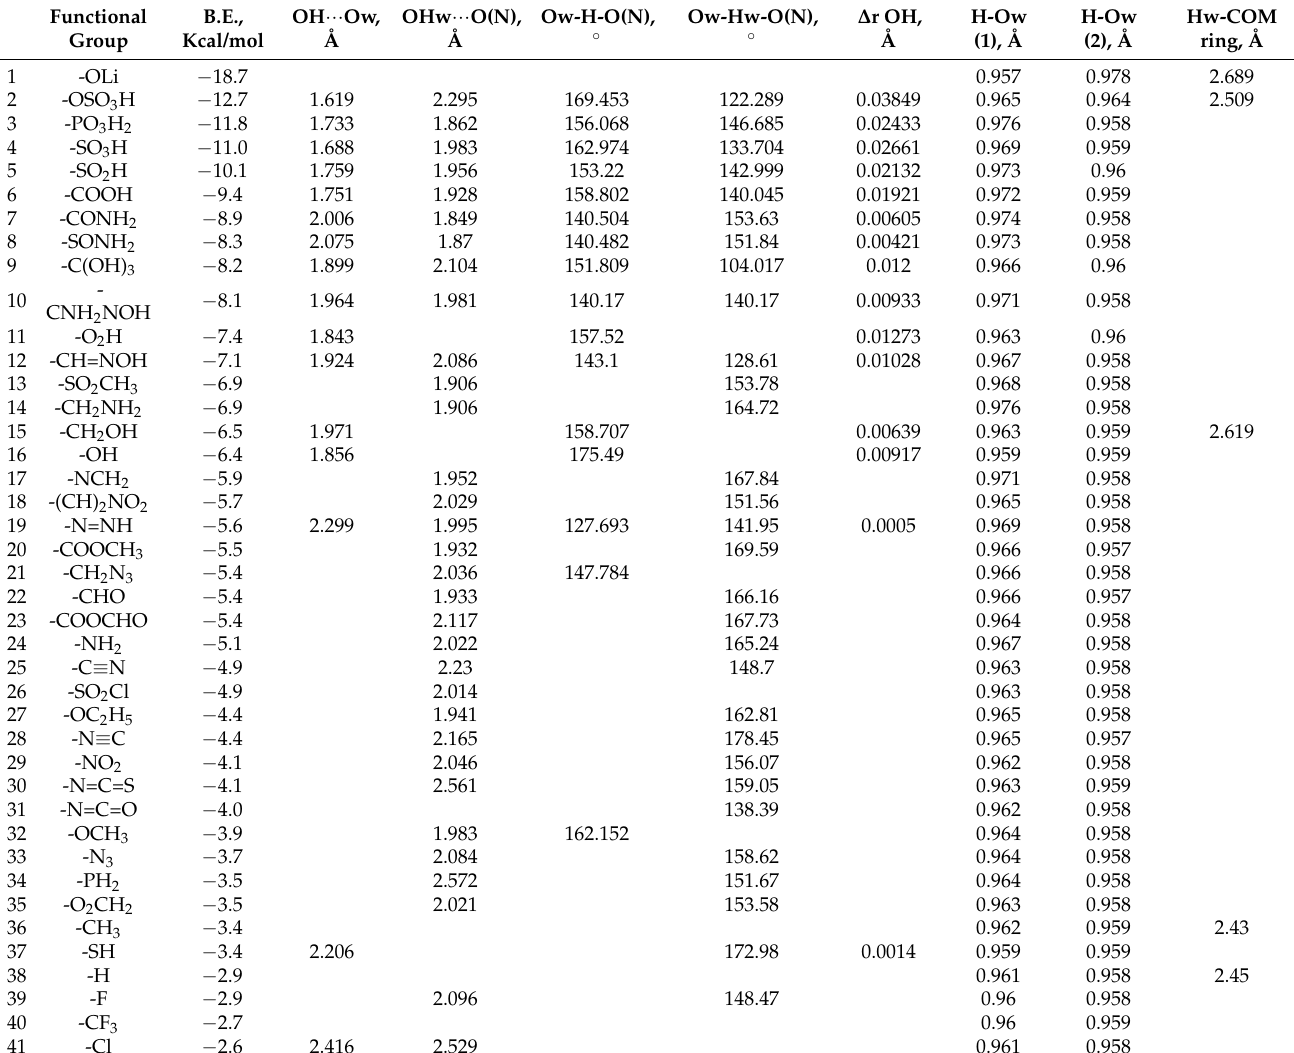
Table 2. Summary of the geometrical parameters of the interaction of the water molecule with the functionalized benzenes obtained at the RI-MP2/def2-TZVPP-level. Binding energies (B.E.), bond lengths and bond angles are in Kcal/mol, Å and degrees ( ◦ )